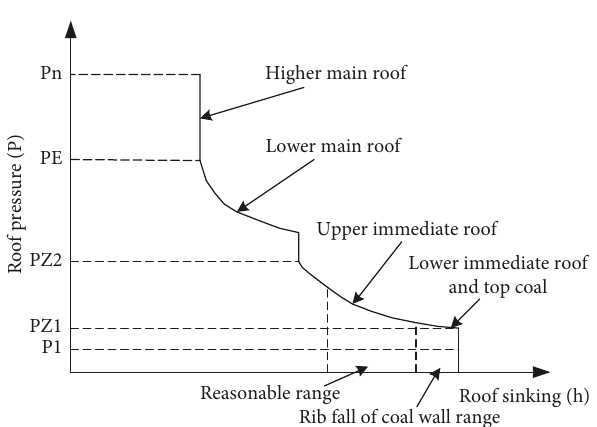
Figure 13: Relationship between support and sinking in extrathick coal seam fully mechanized top-coal caving mining.